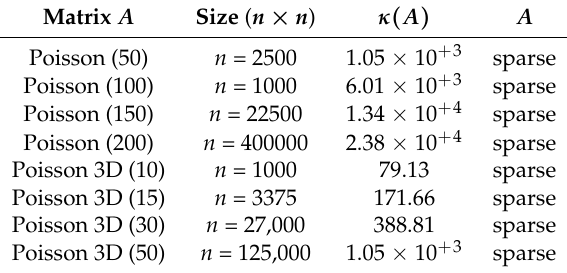
Table 1. Considered test matrices and their